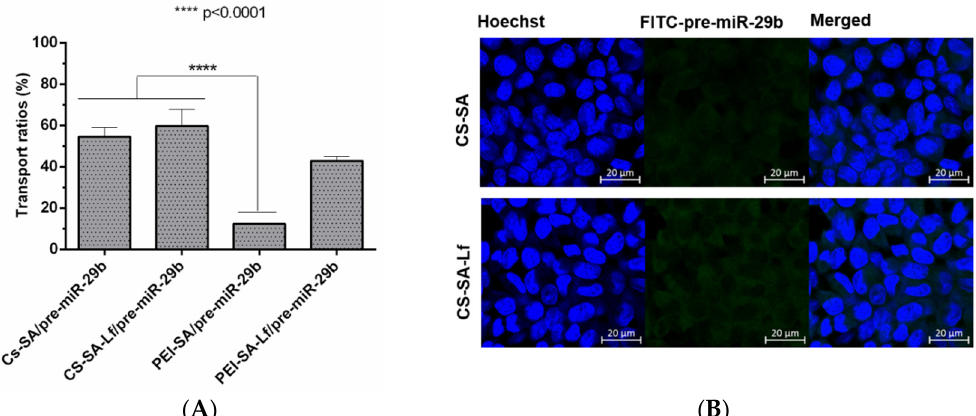
Figure 8. The transport ratio of pre-miR-29b across the blood–brain barrier BBB during 4 h in RBE4 cells. ( A ) Intracellular cells after treating with CS-SA/pre-miR-29b-FITC (35 N/P ratio), CS-SA-Lf/pre-miR-29b-FITC (35 N/P ratio), PEI-SA/pre-miR-29b-FITC (15 N/P ratio), and PEI-SA-Lf/pre-miR-29b-FITC (15 N/P ratio). Quantification of fluorescence intensity for FITC was performed in the fluorimeter. Error bars represent standard deviations derived from three or more independent experiments performed in triplicate. ANOVA, mean ± SD. ( B ) Representative confocal microscopy images of RBE4 cells cultured in the transwells treated with CS-SA/pre-miR-29b-FITC and PEI-SA-LF/pre-miR-29b-FITC. The fluorescence signals were collected by LSCM with three channels: blue fluorescence from nuclei stained with 33342 ® (blue), green fluorescence from FITC labeled pre-miR-29b and the merged images of three channels. Scale bars 20 μ m.